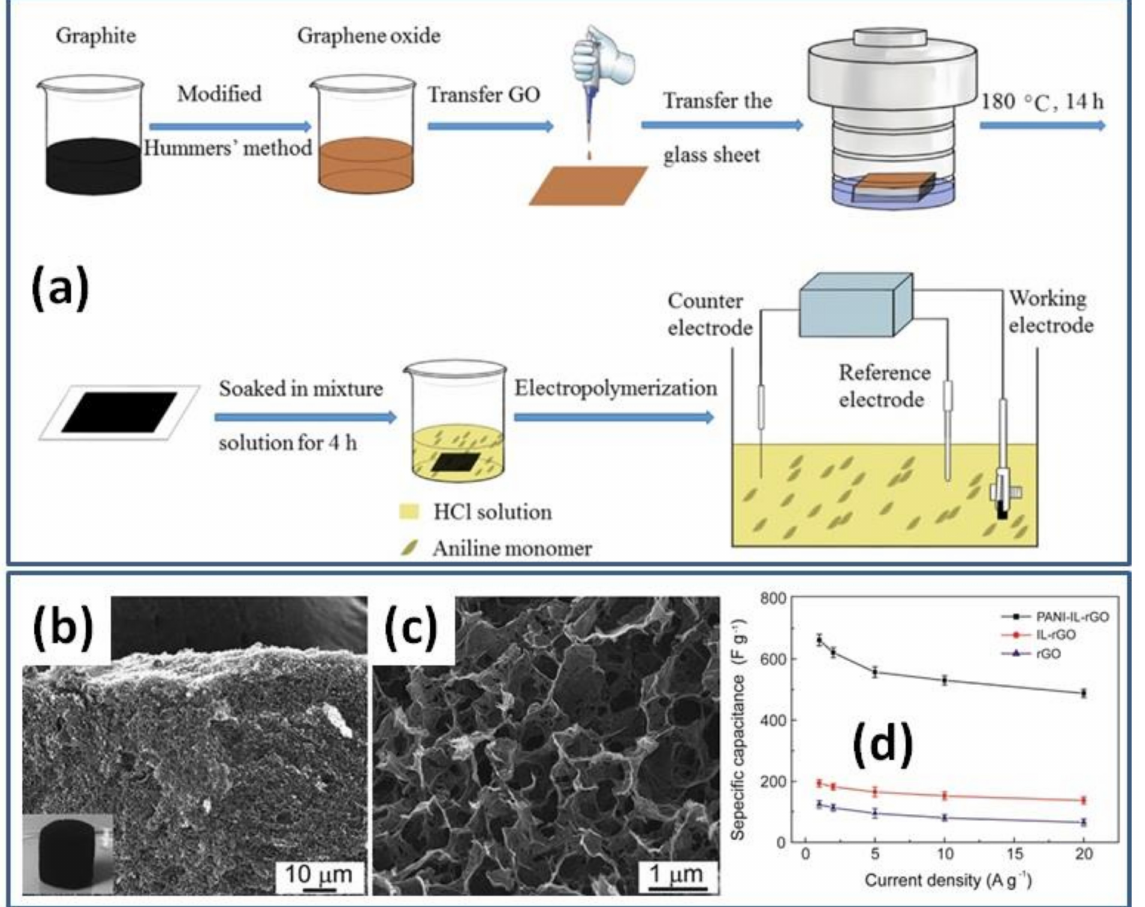
Figure 8. Illustration for the fabrication process of PANI/rGO composite hydrogel film ( a ) (Reprinted from [50], Copyright 2021, with permission of Elsevier). Microstructures of freeze-dried sponge-like IL-rGO ( b ) and PANI-IL-rGO nanocomposite ( c ). Specific capacitances of PANI-IL-rGO, IL-rGO and rGO electrodes versus discharge current densities ( d ) (Reprinted from [62], Copyright 2016, with permission of